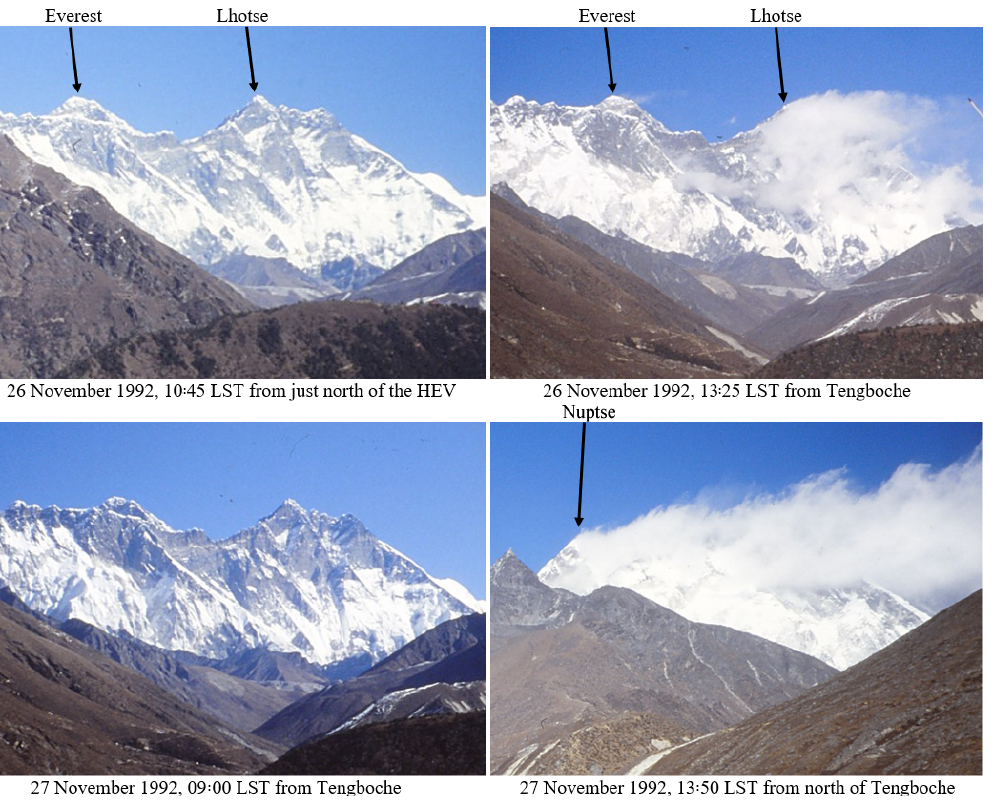
Figure 3. The plumes studied by Hindman and Engber (1995) photographed from the Nepal side of the Everest massif during Hindman’s trek to Everest’s